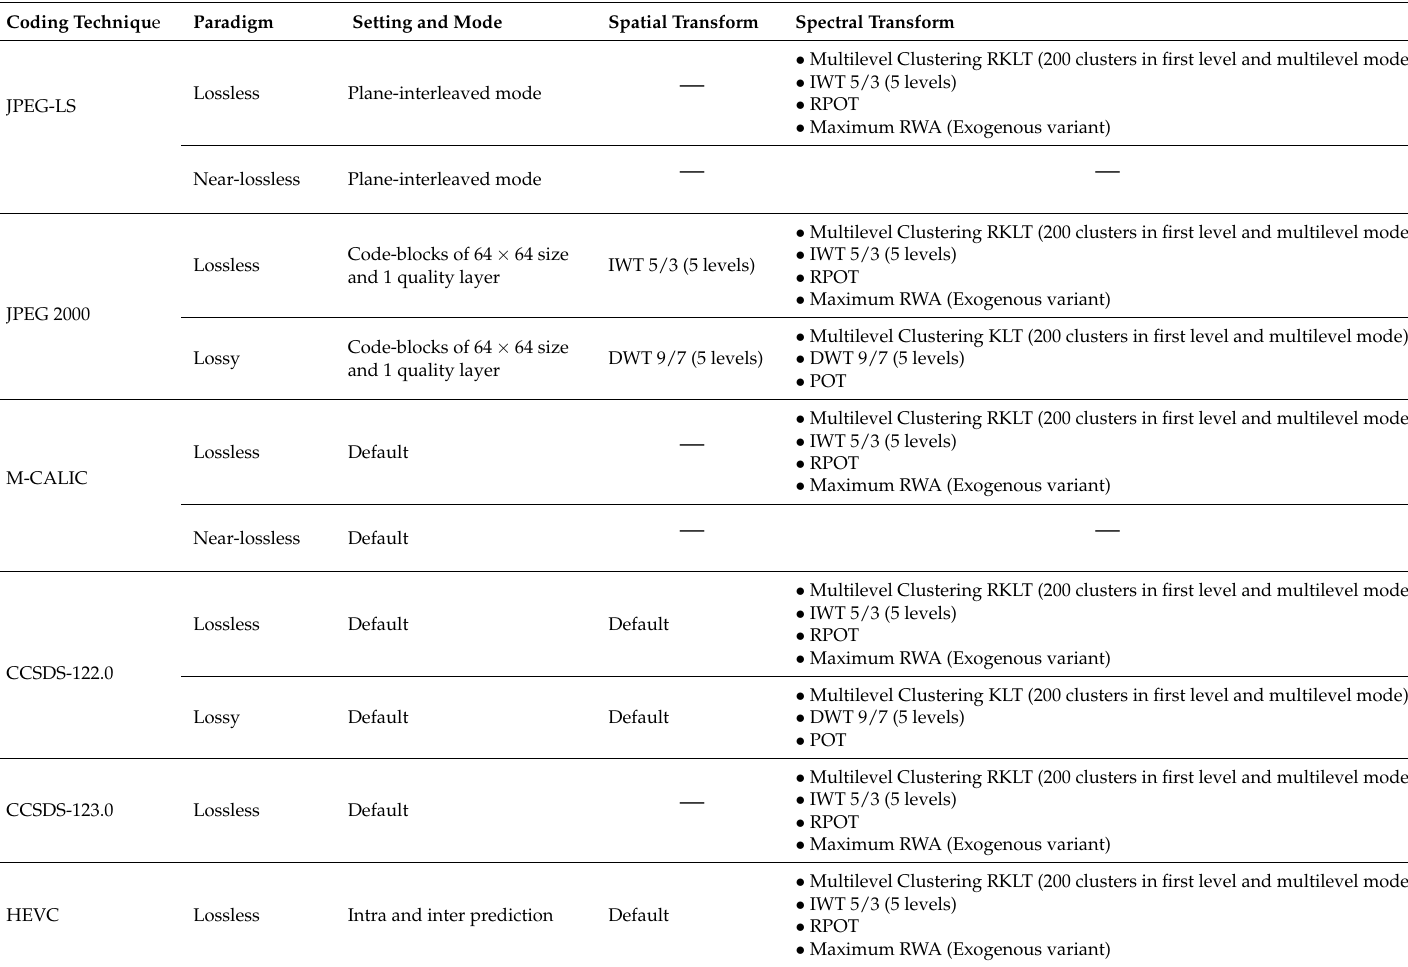
Table 4. For each coding technique, the configuration used in the experiments is reported. Default option is employed for the parameters not specified in the